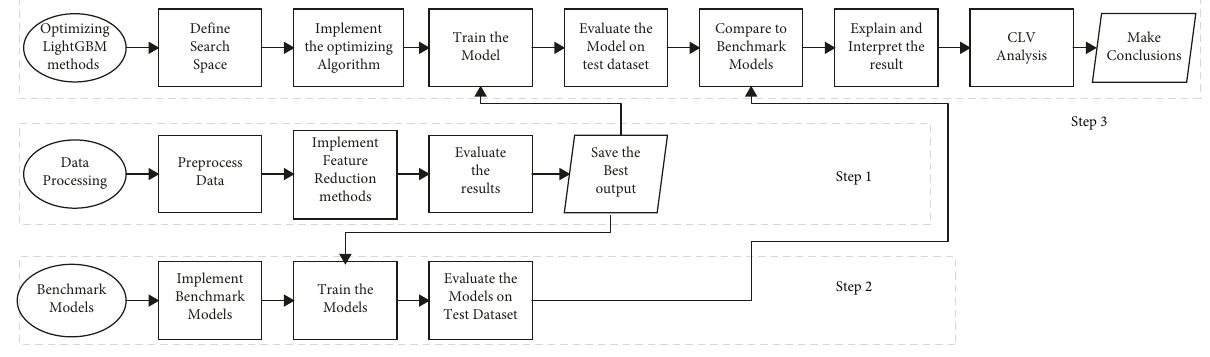
Figure 5: Flowchart of proposed